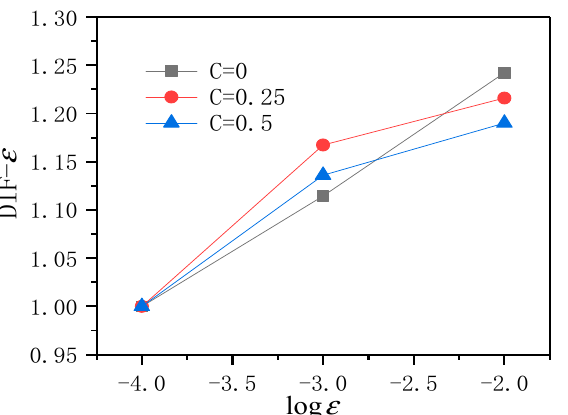
Figure 8. The broken line graph of DIF − ε of ECC with dynamic strain rate under different lateral pressure levels.